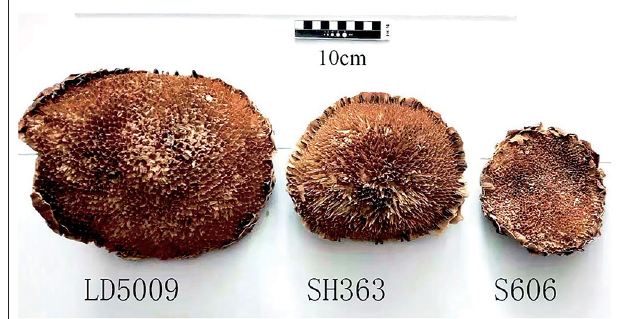
FIGURE 1 | Sunflower receptacles from the three varieties of sunflowers.